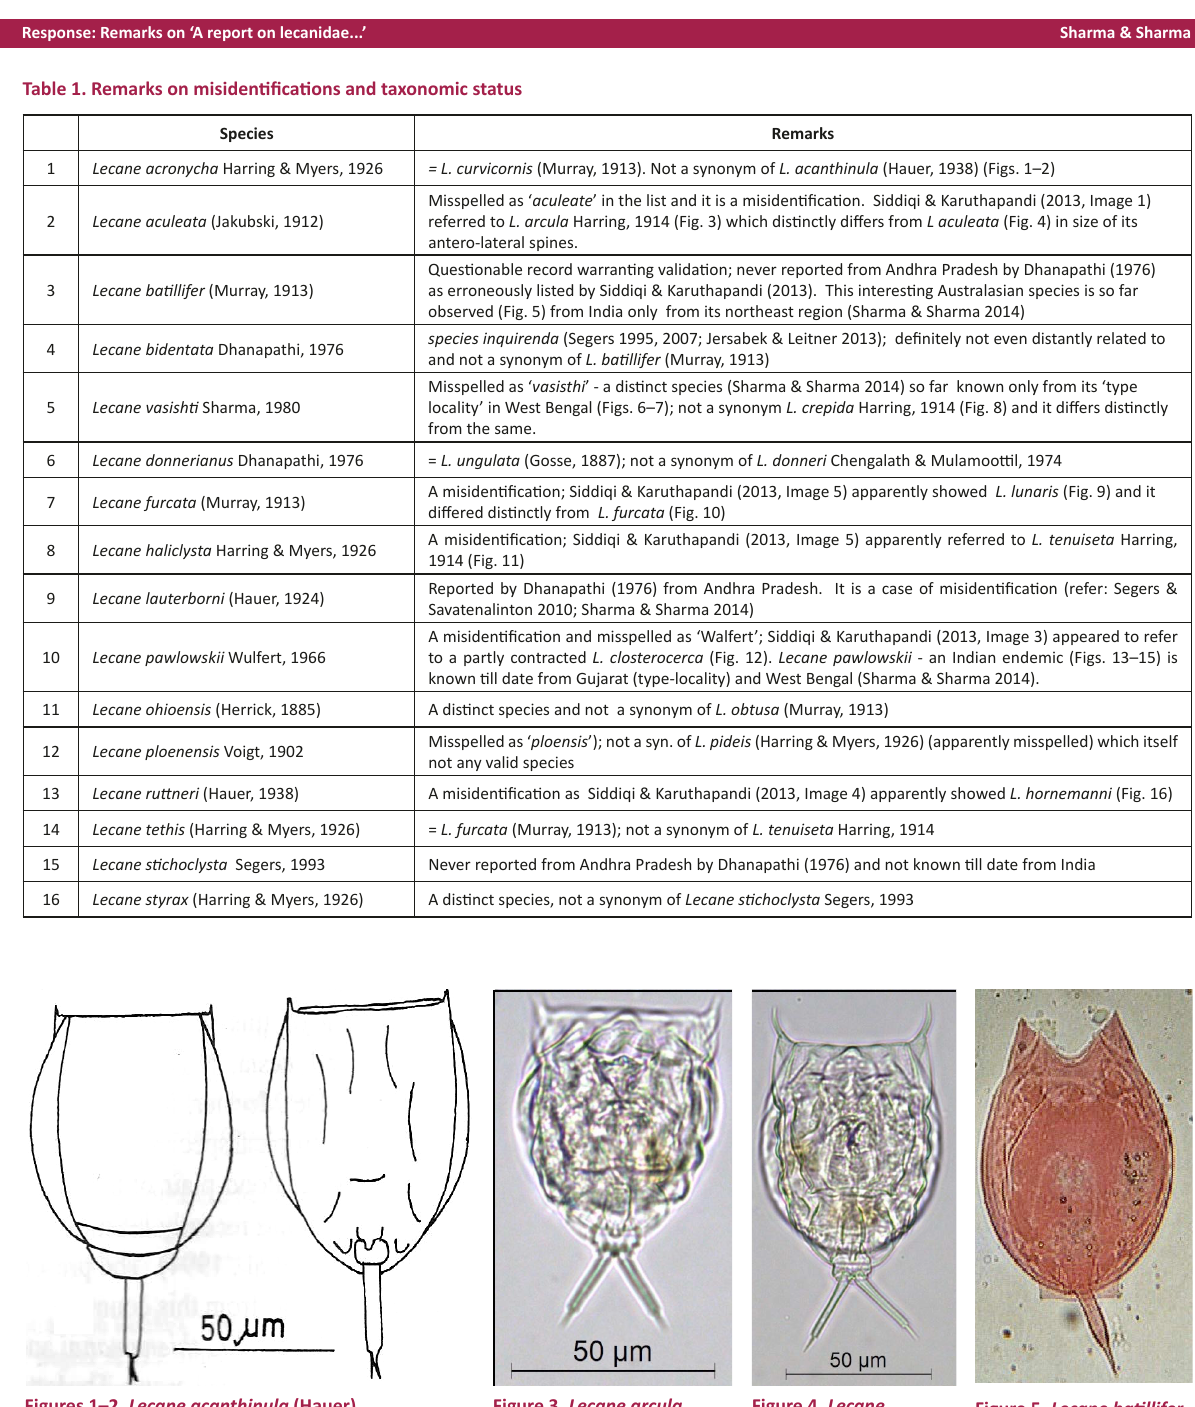
Figure 3. Lecane arcula Harring